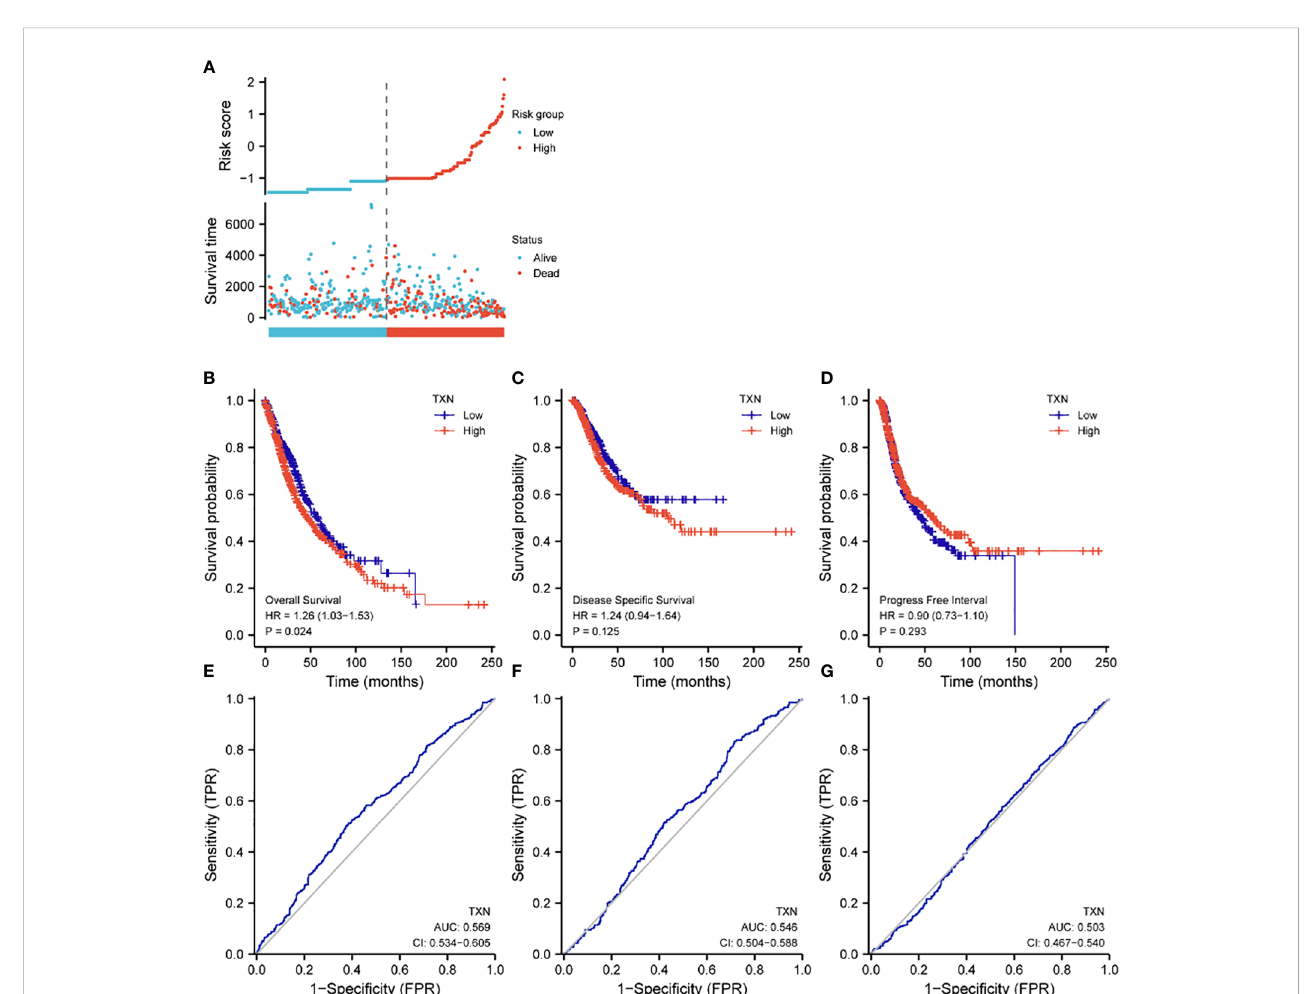
FIGURE 8 Effects of TXN expression on survival outcomes in lung cancer patients, as determined by KM survival analysis and ROC curve analysis. (A) Relationships of TXNexpression with risk scores and individual patient survival; (B – D) KM analysis ofthe relationships betweenTXN expressionand patient (B) OS, (C) DSSand (D) PFI. (E – G) ROCcurve analysis of the relationships between TXNexpression and patient (E) OS, (F) DSS and (G)